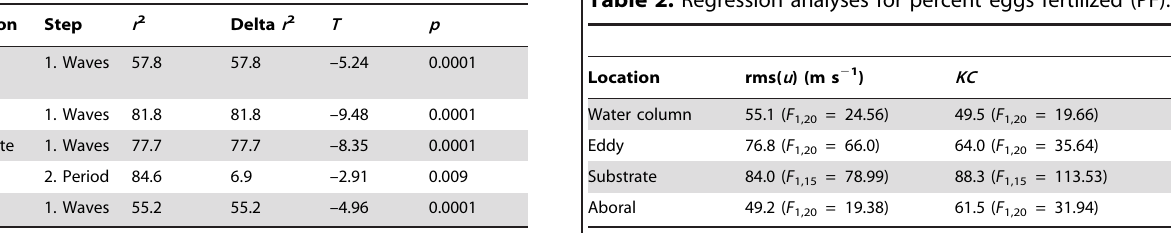
Table 2. Regression analyses for percent eggs fertilized